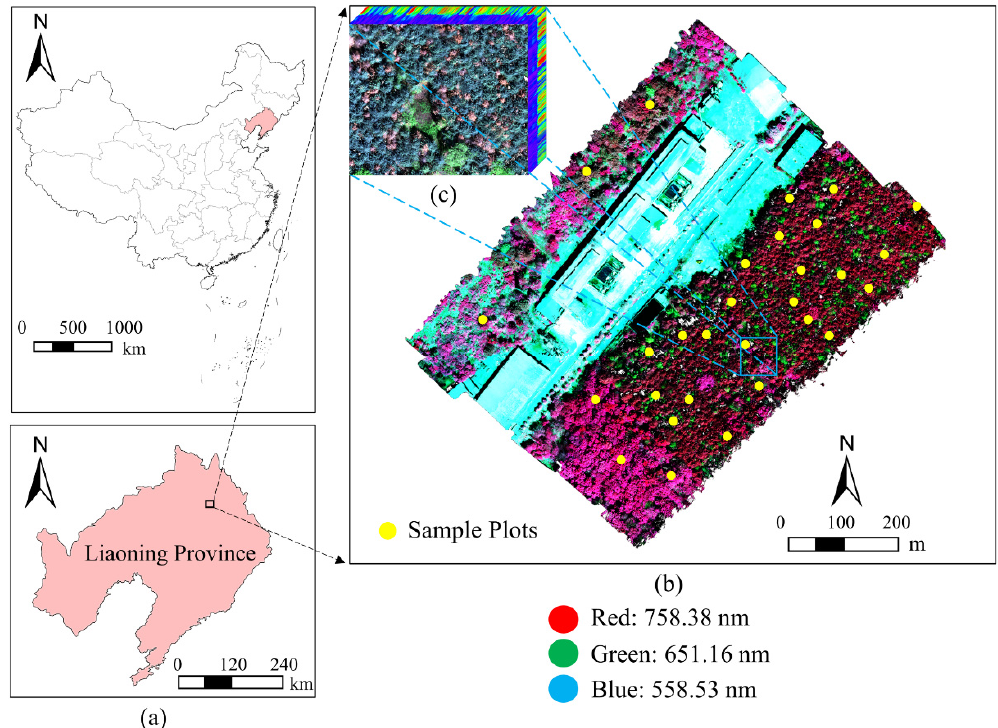
Figure 6. Study area. ( a ) Location of the study area; ( b ) the hyperspectral image (in false color composition) and location of sample plots; ( c ) the hyperspectral cube of the corresponding area from the hyperspectral image.